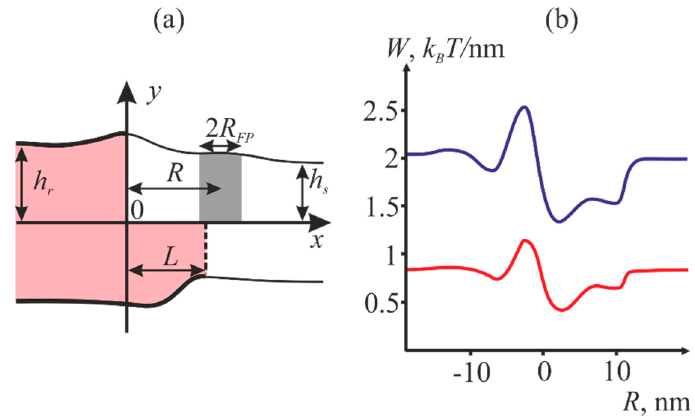
Figure 2. ( a ) Schematic representation of the model of a peptide incorporated into the membrane with the raft. The raft area is shaded in pink and outlined by bold lines, the surrounding membrane is shown in white and outlined by thin lines. L designates the shift of the monolayer raft boundaries. The area occupied by fusion peptides is shown in gray. The width of the fusion peptide is 2 R FP . The distance from the center of fusion peptide to the center of coordinates is designated as R . ( b ) Dependence of the equilibrium energy of the membrane W (expressed as the energy per unit length of the raft boundary) upon the coordinate R of the fusion peptide. The blue curve corresponds to the case of the half-width R FP equal to 1 nm, the red one—to the case of the half-width R FP equal to 0.5 nm. The equilibrium thicknesses of the raft monolayer and the monolayer of the surrounding membrane are designated as h r and h s , respectively.